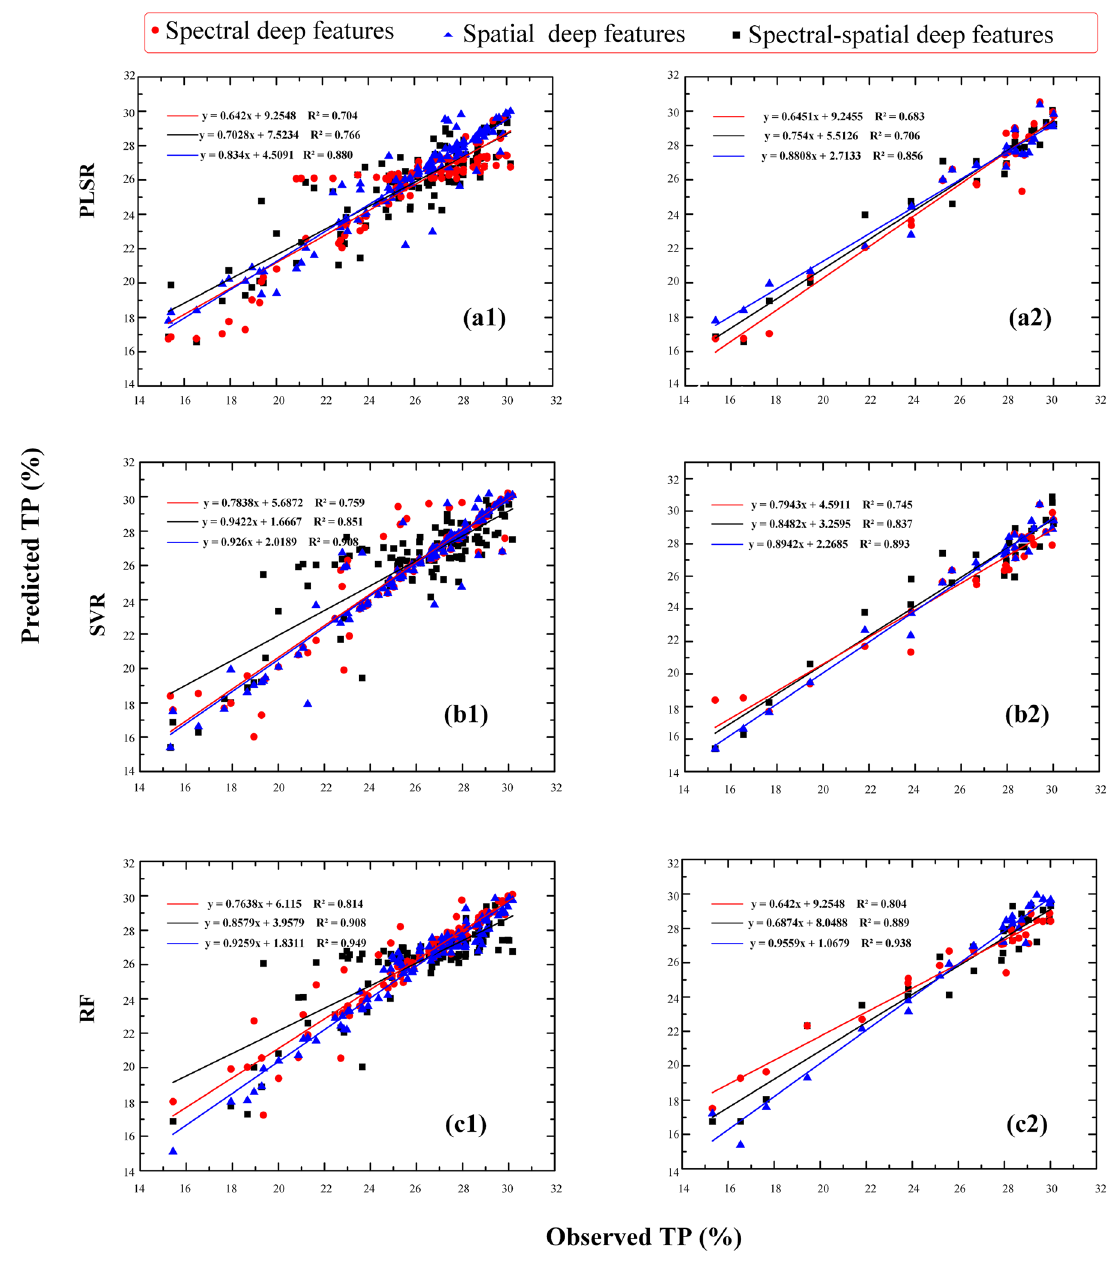
Figure 7. Prediction results of tea polyphenols based on different models with spectral deep features, spatial deep features and spectral-spatial deep features, including PLSR, SVR, RF with training set: ( a1 , b1 , c1 ), and test set: ( a2 , b2 , c2